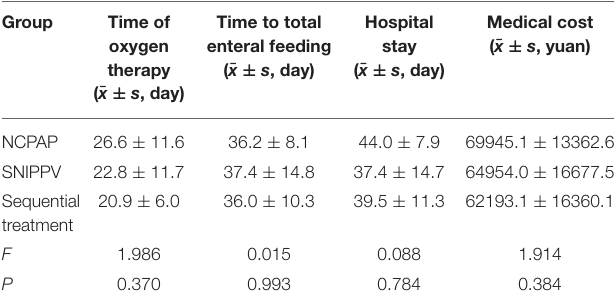
TABLE 5 | Time of oxygen therapy, time to total enteral feeding, hospital stay and medical cost in three groups. Group